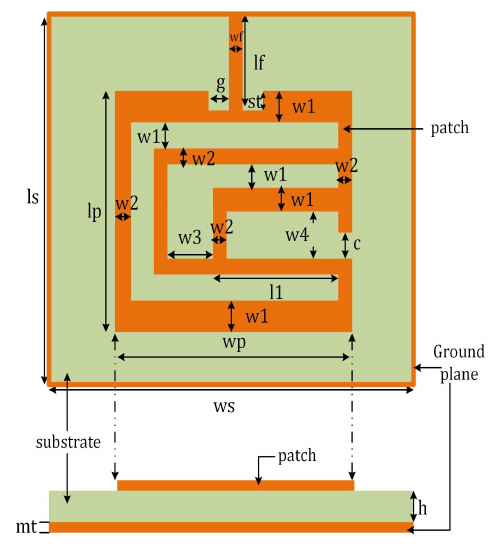
Figure 1. Geometrical model of the proposed dual band microstrip patch